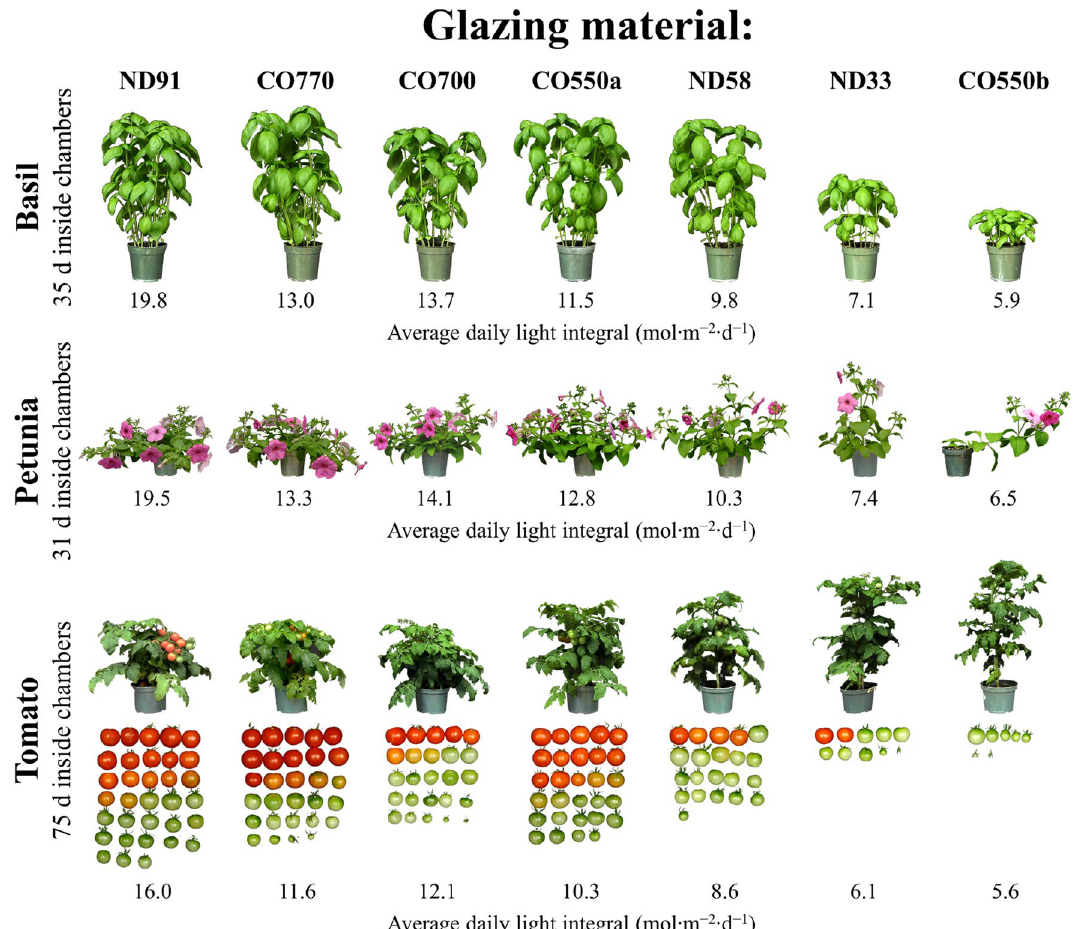
Figure 4. Representative plants under each glazing material. Photos of basil, petunia, and tomato plants representative of those grown under various experimental glazing materials on 16 June 2020, 21 July 2020, and 13 Oct. 2020, respectively. The transmission spectra for the different glazing materials are given in Fig.